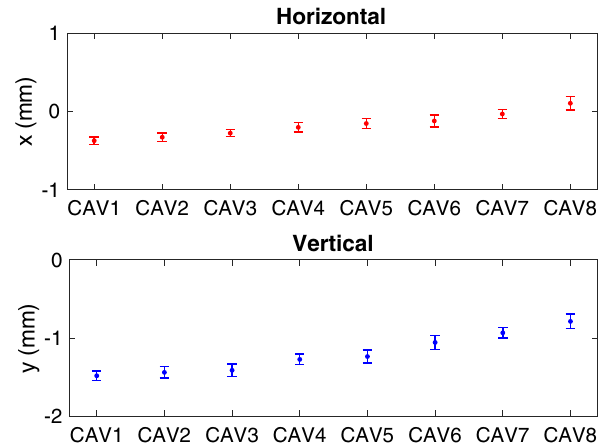
FIG. 19. Readings of the eight HOMBPMs during normal beam operation in